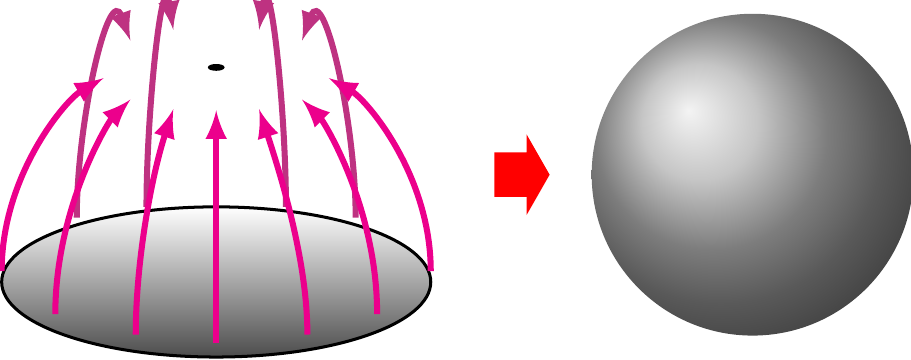
Figure 12. A cellular decomposition of the sphere: a disc is glued to a point.